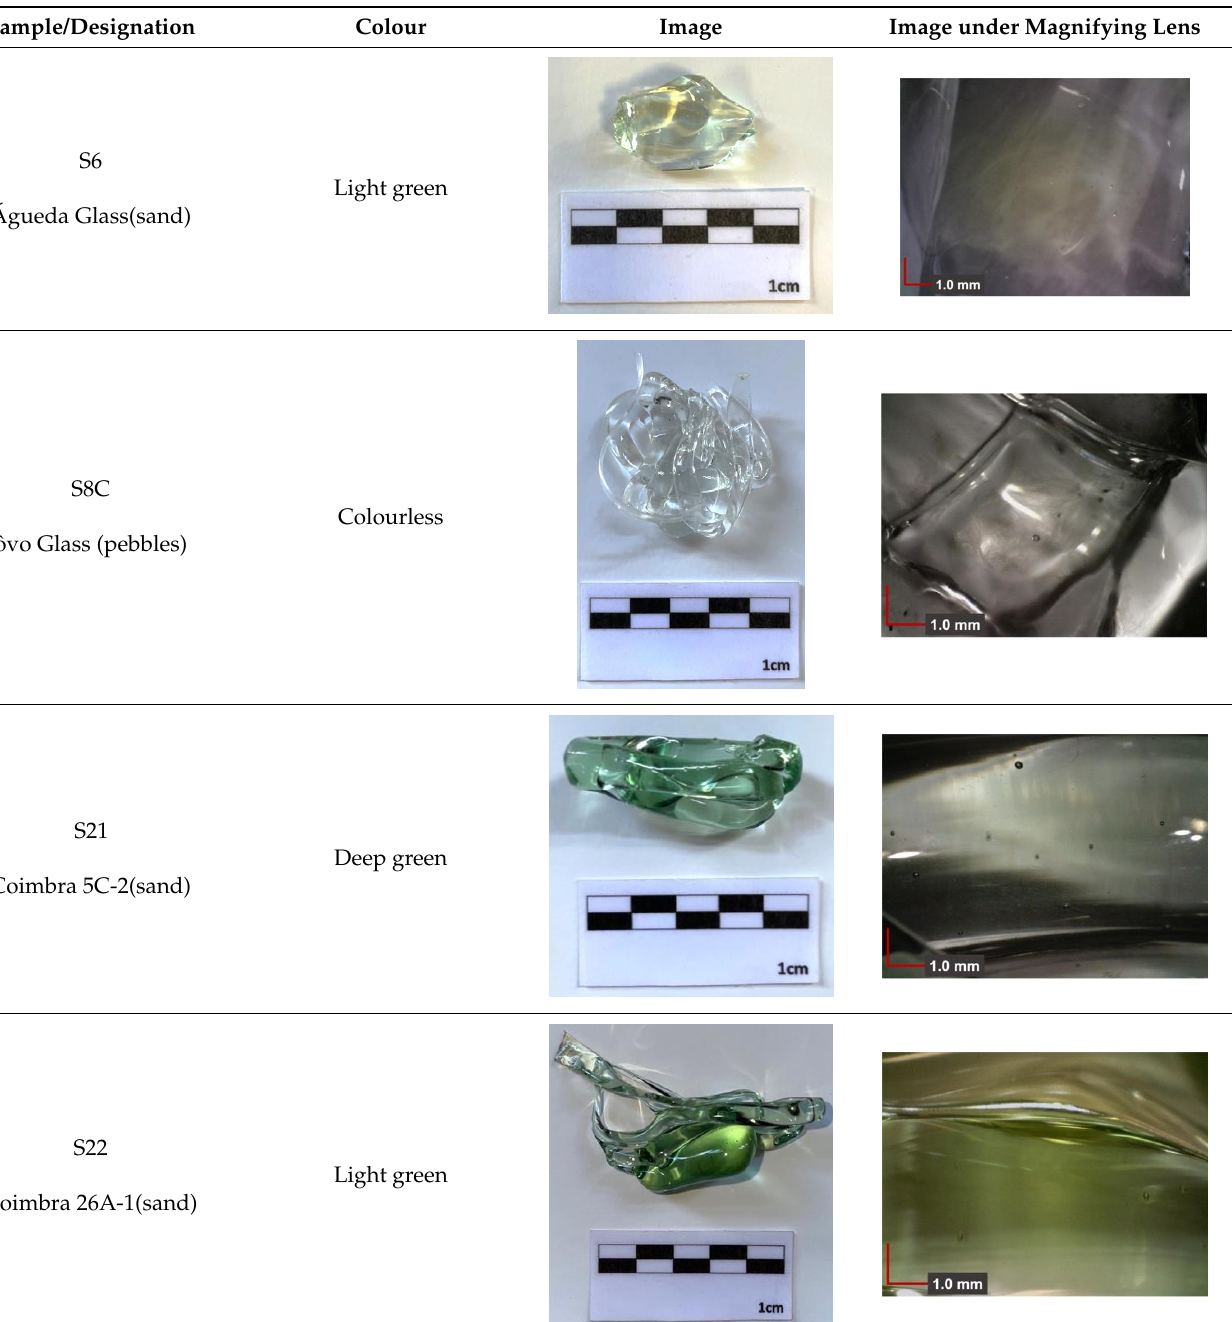
Table 4. Sample location and designation, colour and image of the resulting synthesised glasses. Magnified images were obtained with a Dino-lite ® Edge Digital Microscope.